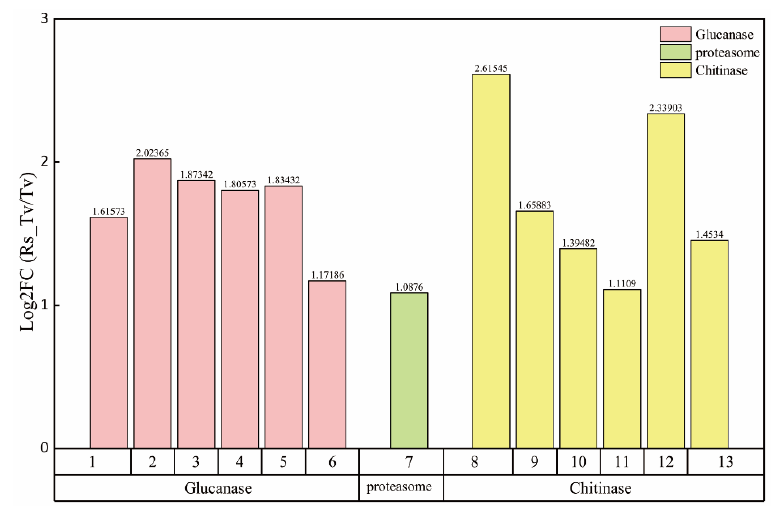
Figure 7. Chitinase, glucanase, and protease genes from T. virens ZT05. 1, 2, 3, 4, 5, 6, 7, 8, 9, 10, 11, 12, and 13 represent